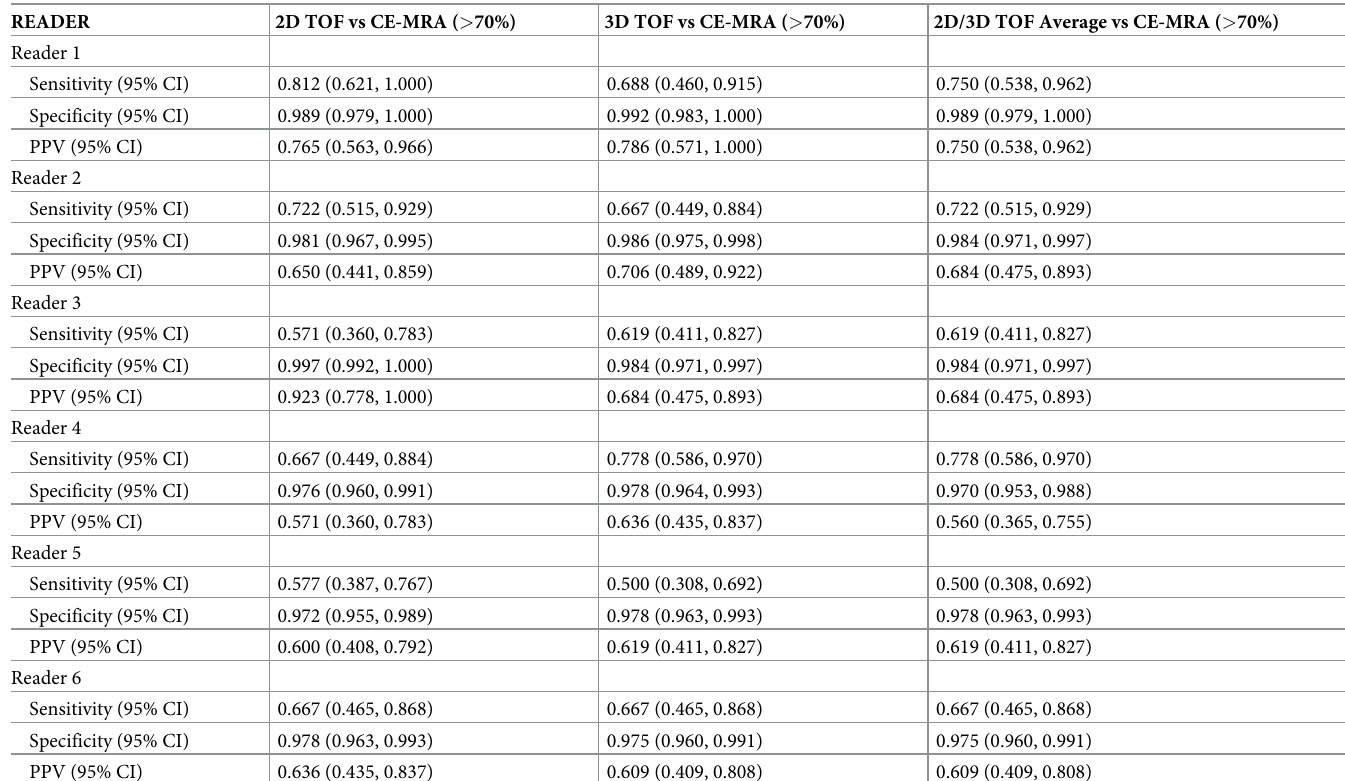
Table 5. Sensitivity/specificity